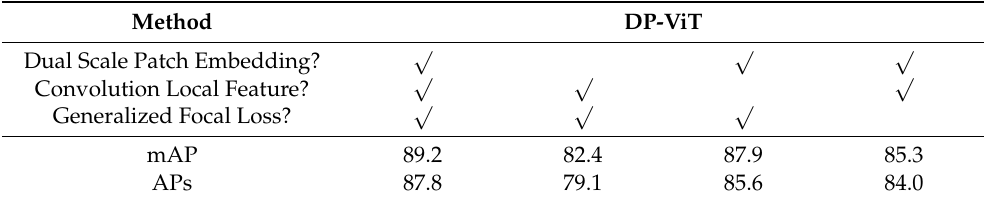
Table 7. Effectiveness of Various